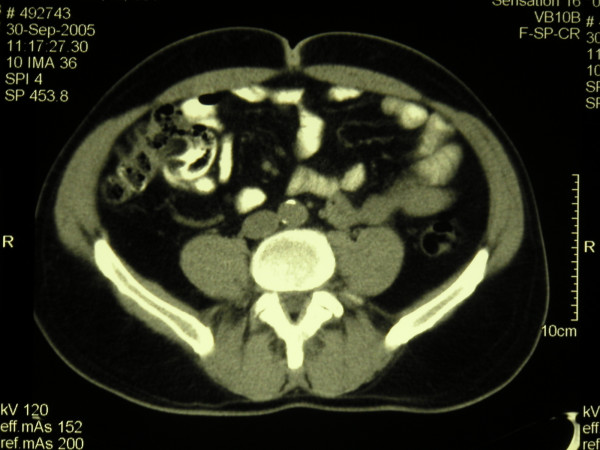
CT scan showing complete regression of mesenteric metastases after chemotherapy.